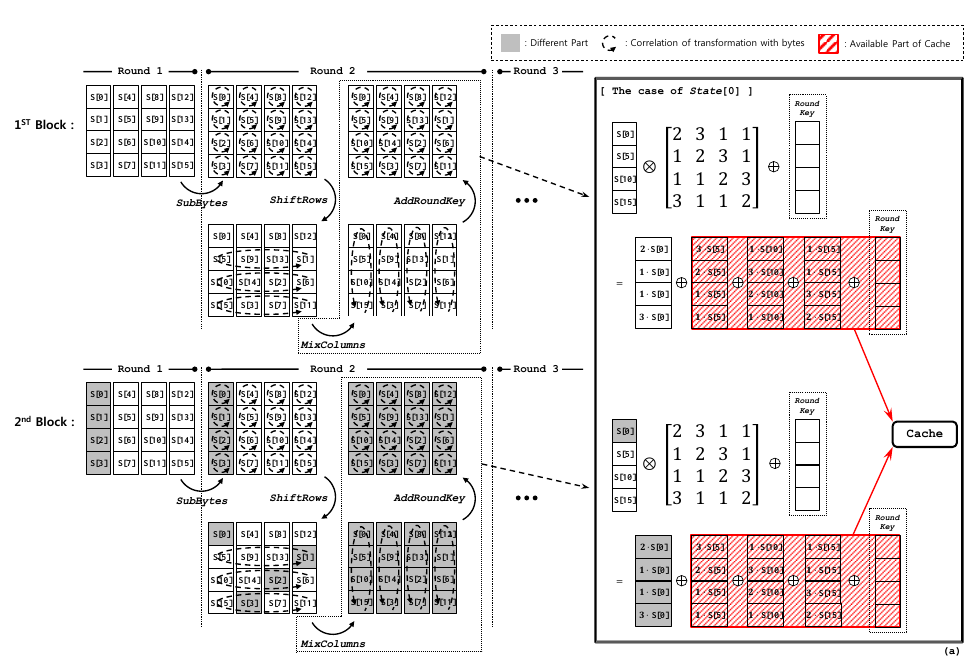
Figure 6: FACE rd 2 : The diffusion process of the difference between the first block and the second block in round 2. (a) indicates the MixColumns() and AddRoundKey() transforma- tions using State [0]. It also shows the available part of the